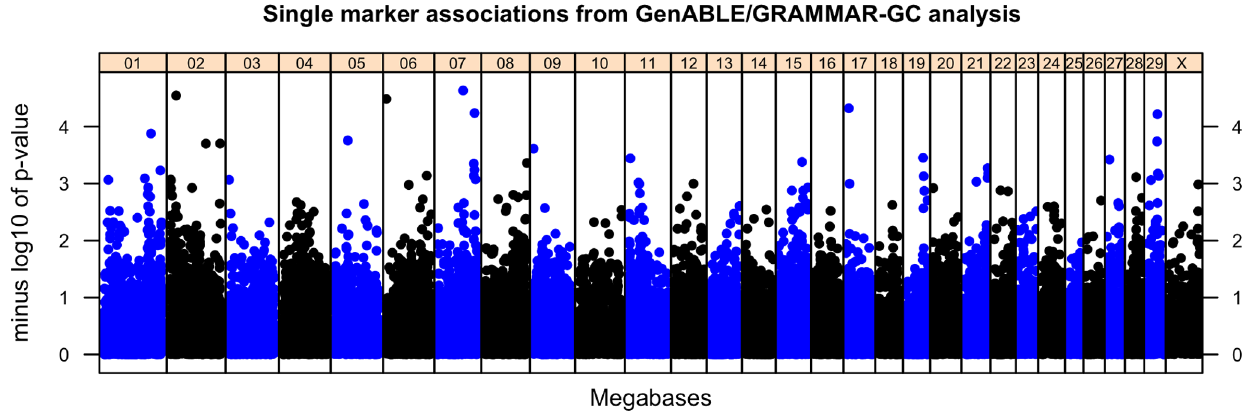
Figure 1. Manhattan plot for single marker (GRAMMAR-GC/GenABLE) analysis of combined discovery and validation data sets. Each dot represents the results from the test of association for a single SNP. Minus log 10 of the p-value is indicated on the y-axis and map location of the SNP is indicated on the